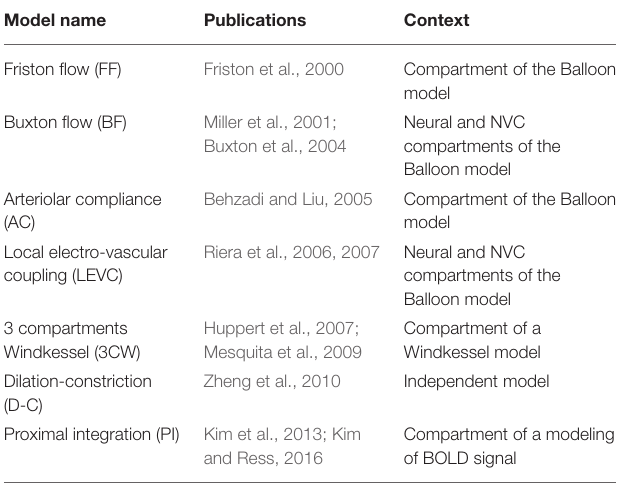
TABLE 1 | The seven dynamic models of neurovascular coupling selected from the